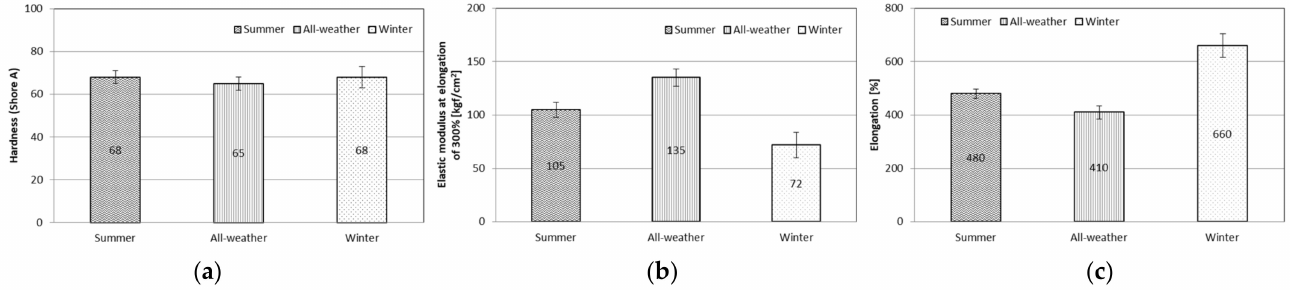
Figure 8. Mechanical properties: ( a ) hardness (Shore A); ( b ) elastic modulus at elongation of 300% (kgf/cm 2 ); ( c ) elongation